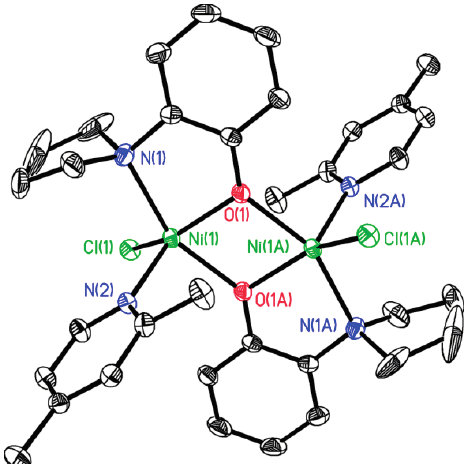
Figure 2. ORTEP diagram of 4 . All hydrogens are removed for clarity. Selected